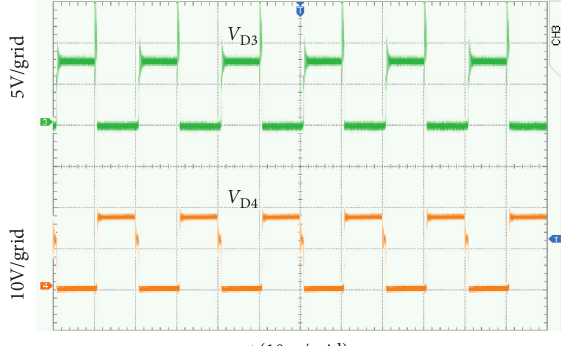
Figure 18: Waveform of V